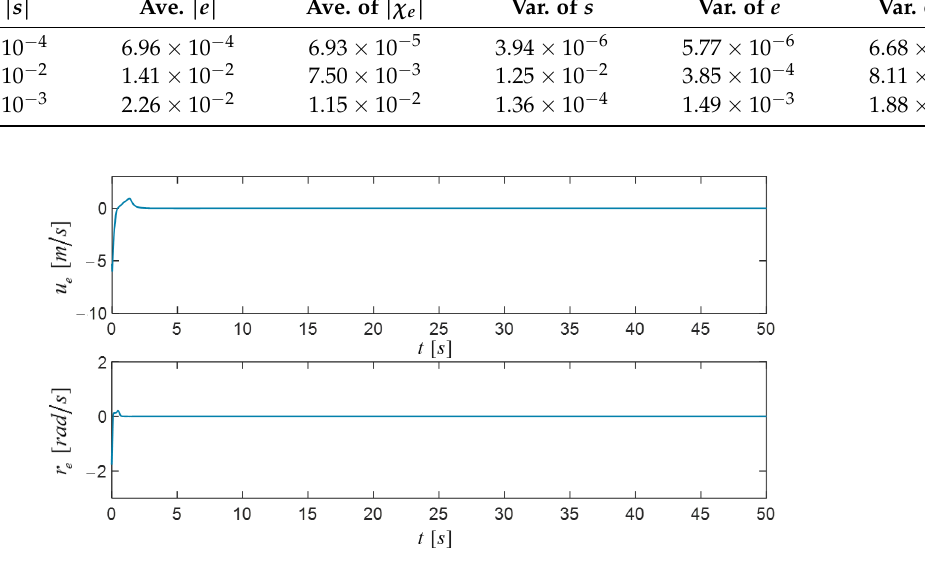
Figure 7. The errors of virtual speed for the proposed method under the influence of